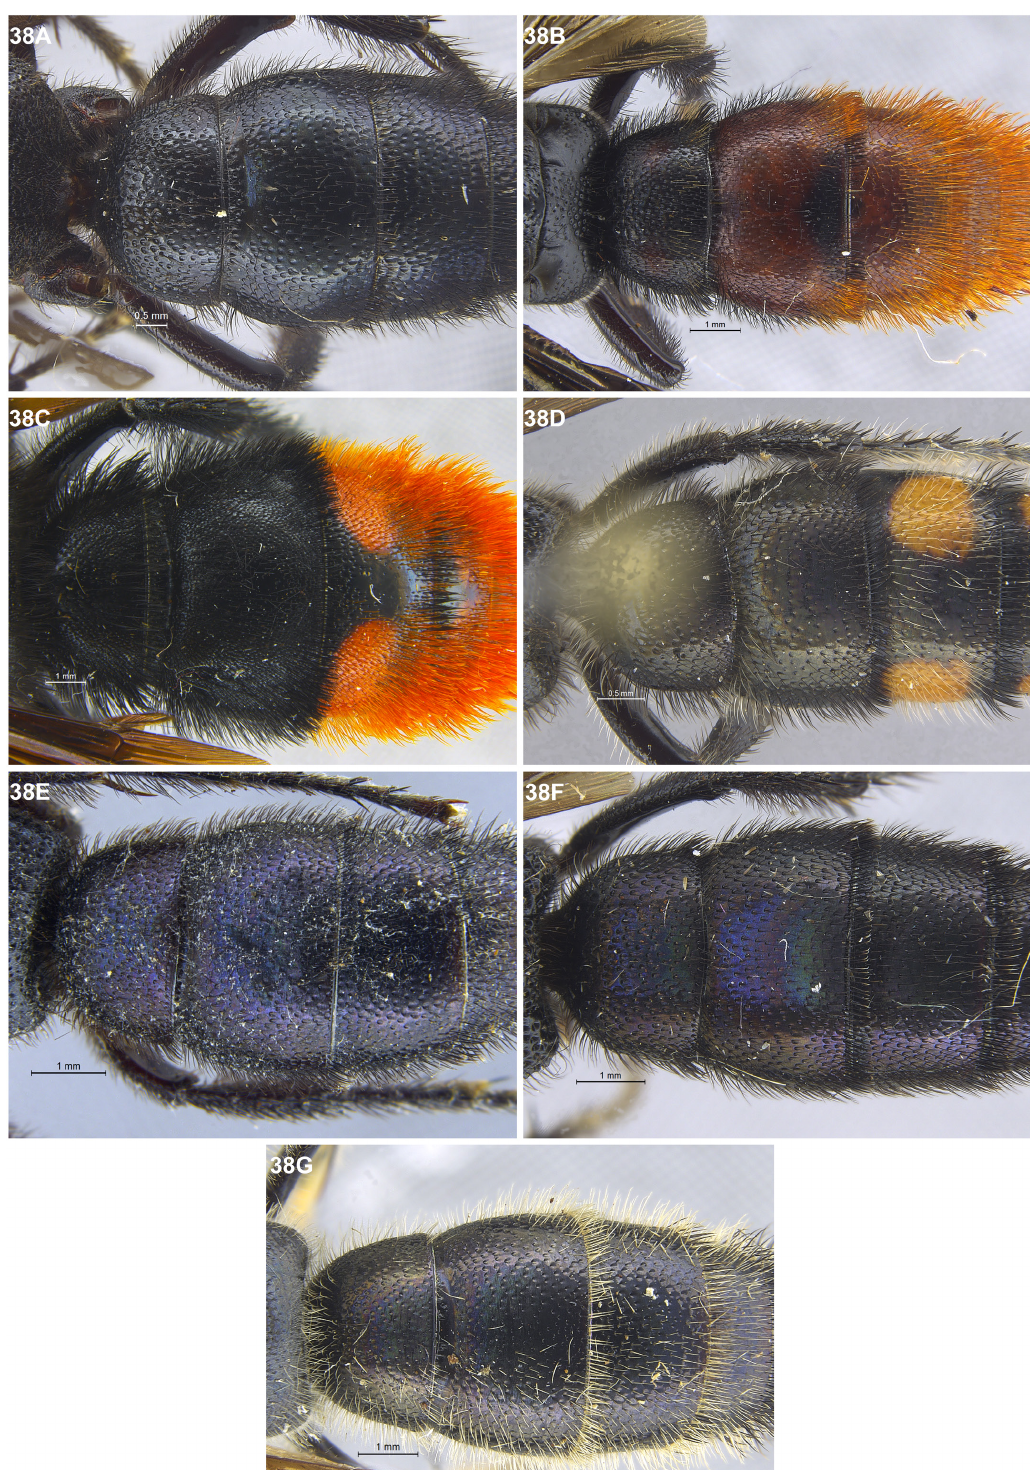
Fig. 38. Males, T1–T3, dorsal view. A . Carinoscolia junnanensis (Betrem, 1928). B . Liacos erythrosoma (Burmeister, 1854). C . Megascolia azurea (Christ, 1791). D . Scolia binotata Fabricius, 1804. E . Sc. laeviceps Smith, 1855. F . Sc. pakshaoensis sp. nov., paratype (CBC). G . Sc . superciliaris de Saussure & Sichel, 1864